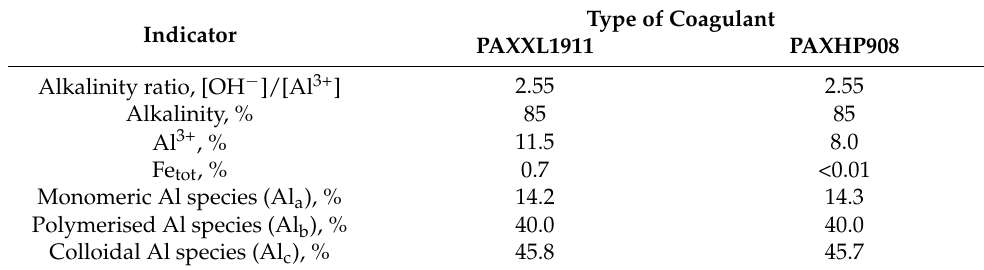
Table 2. Selected properties of the tested